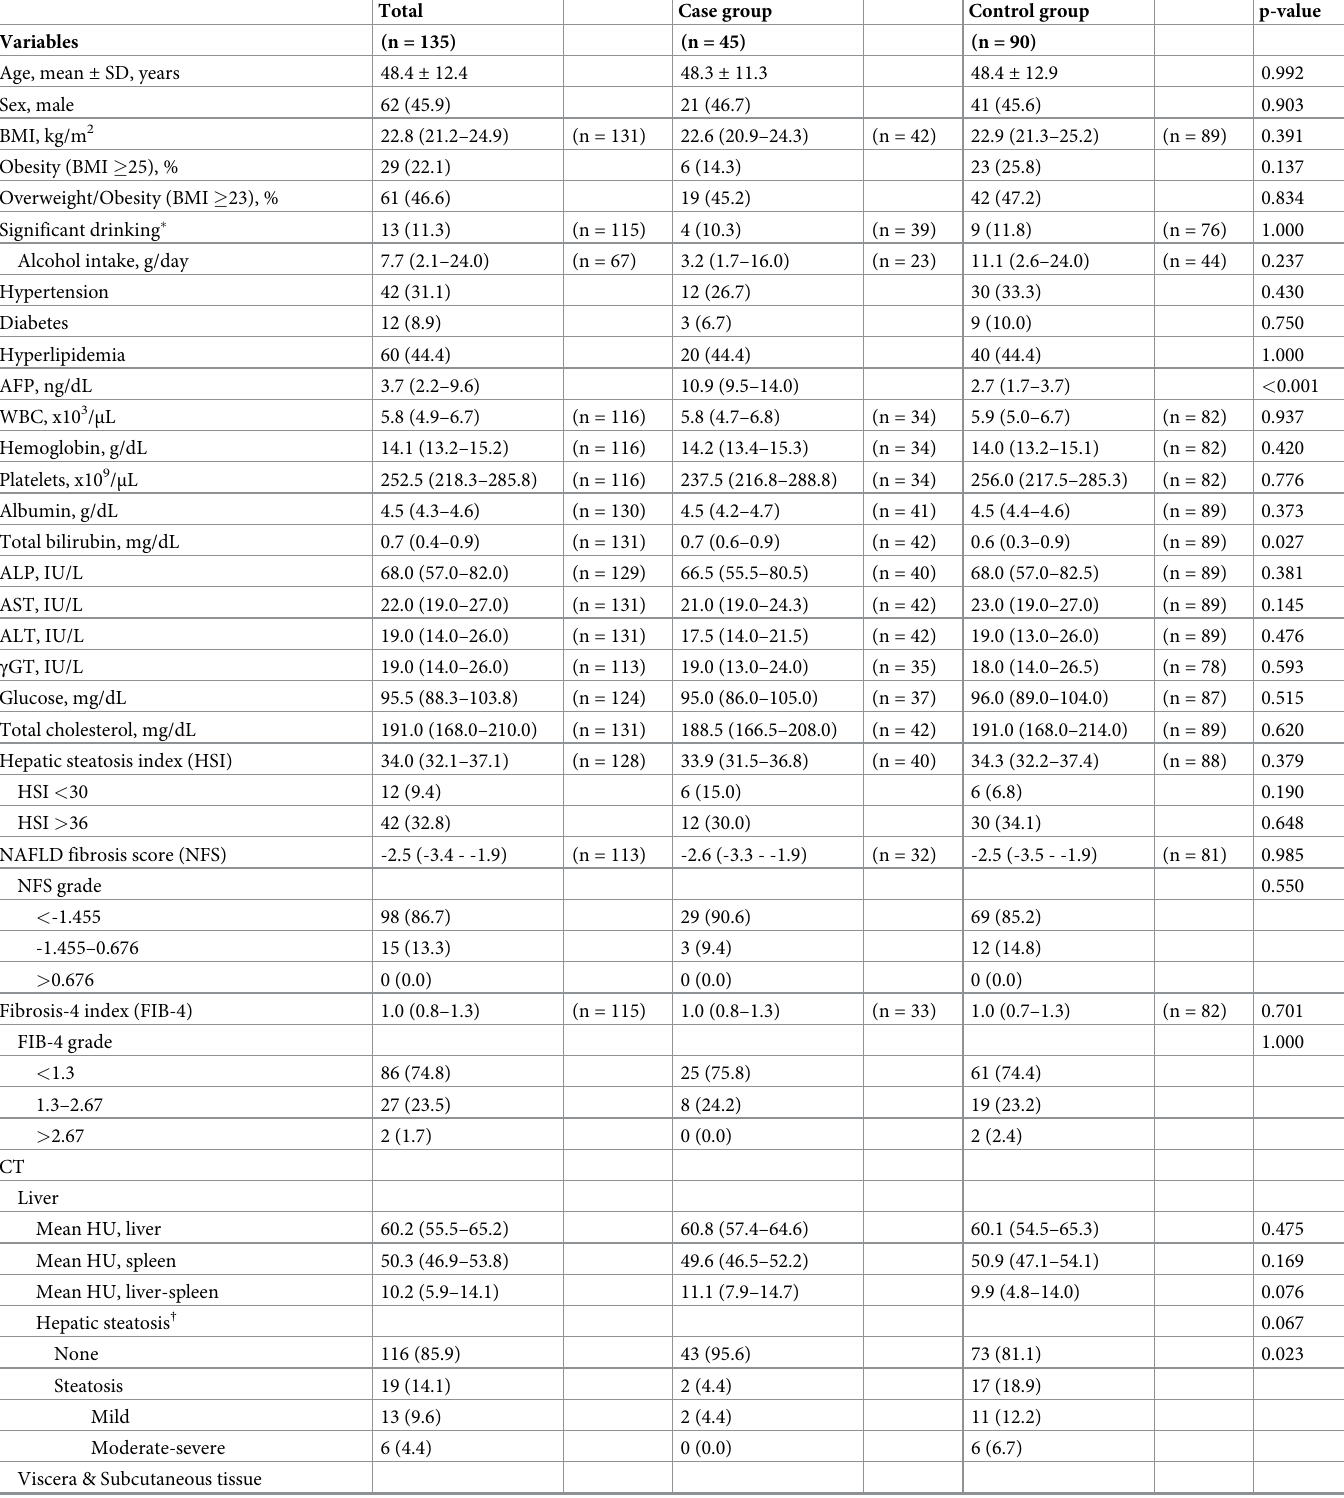
Table 3. Baseline characteristics of the case group in comparison with the control group with CT—a cross-sectional